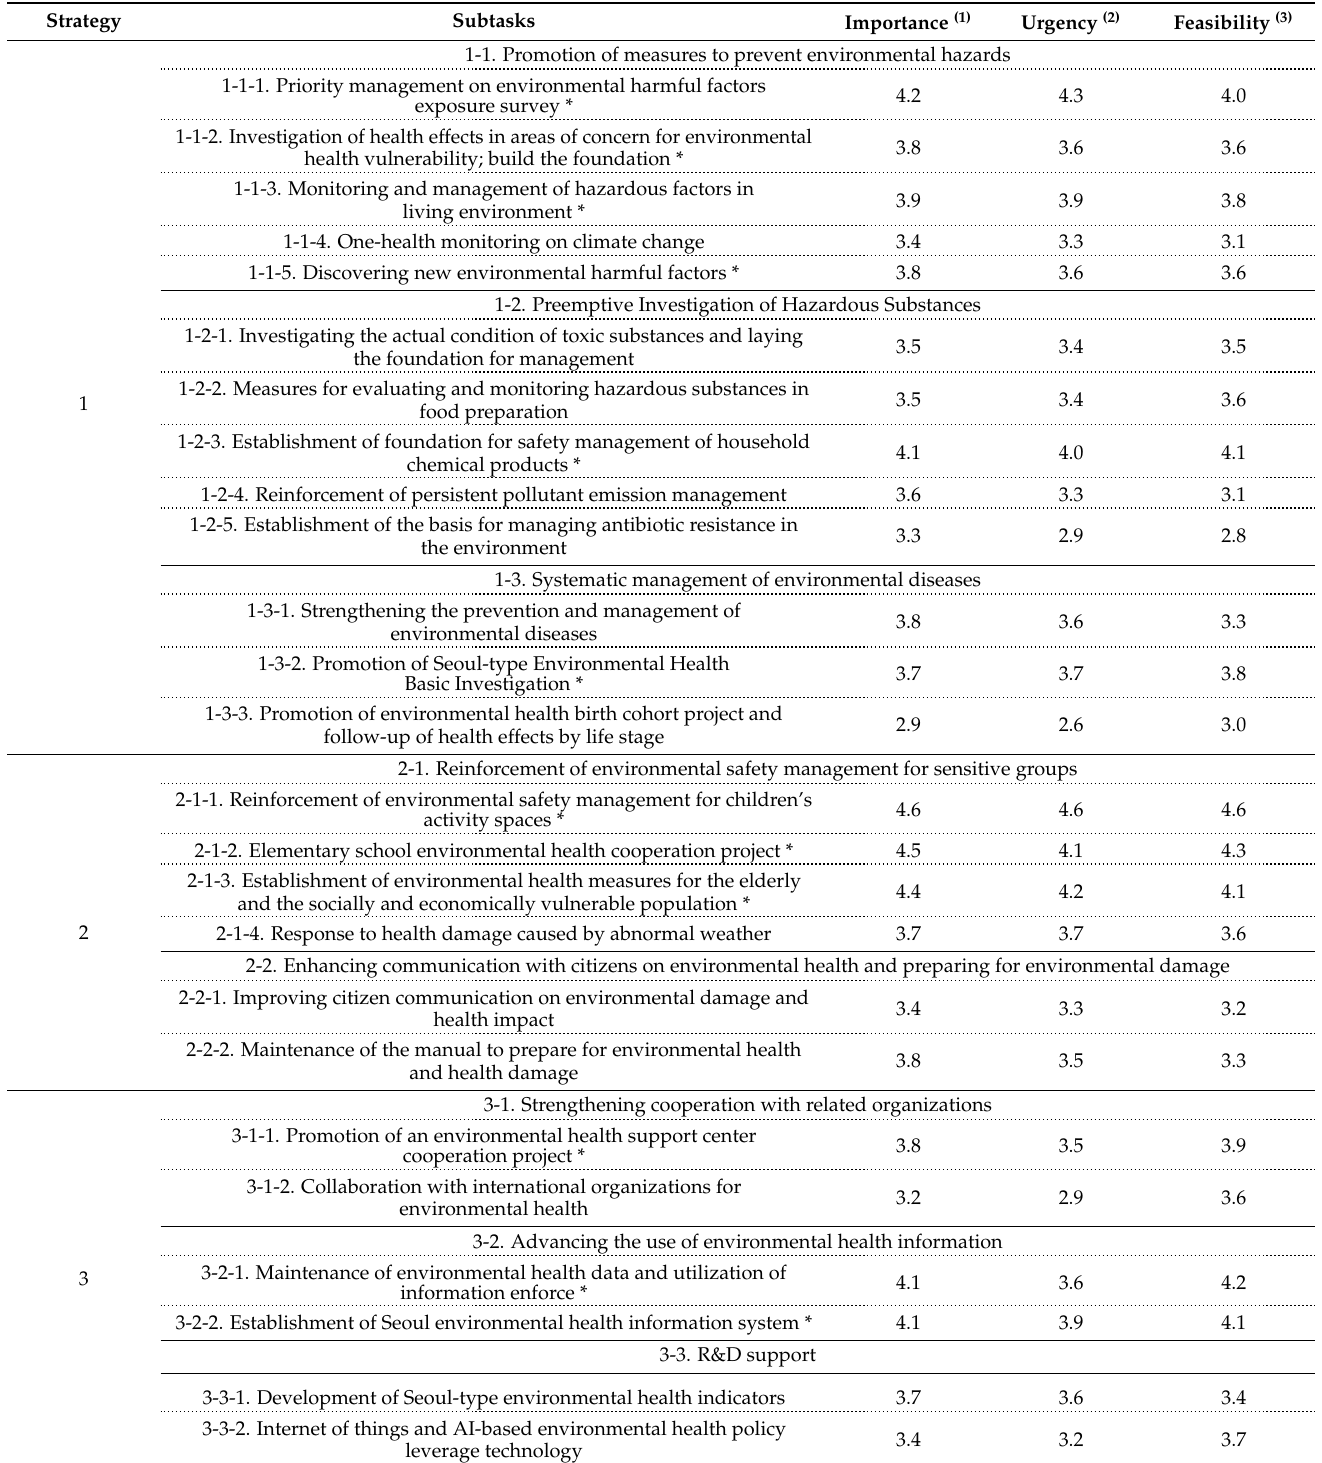
Table 1. The importance, urgency, and feasibility of subtasks with experts’